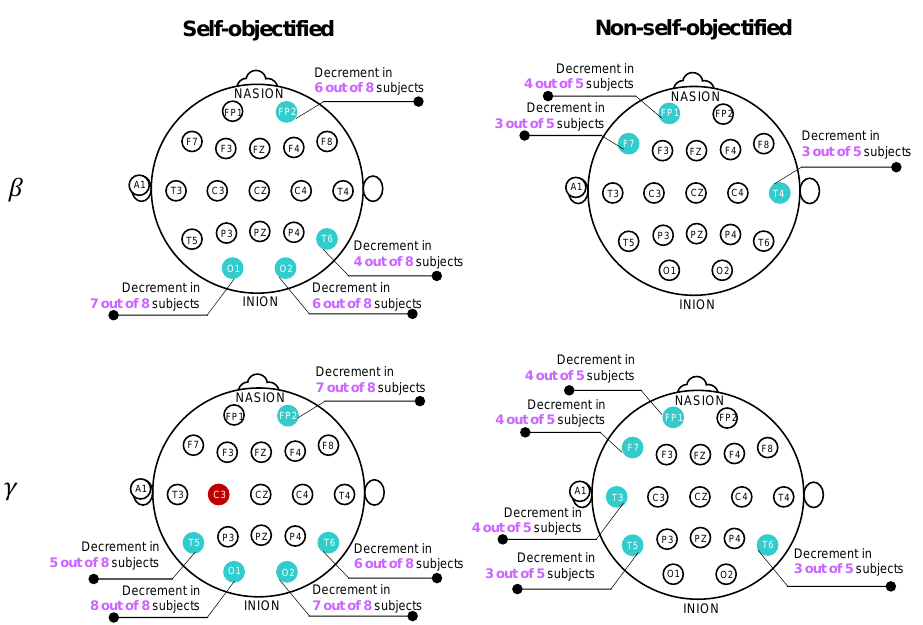
Figure 2. ∆ ERS trends in the beta band of the SOs ( top-left ) and NSOs ( top-right ) and in the gamma band of the SOs ( bottom-left ) and NSOs ( bottom-right